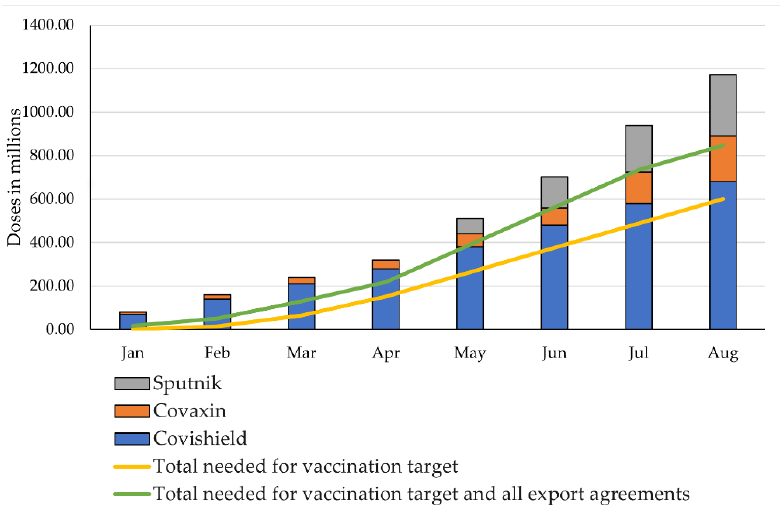
Figure 4. Production capacities (incl. scale-up) vs. vaccination target and total doses needed for all